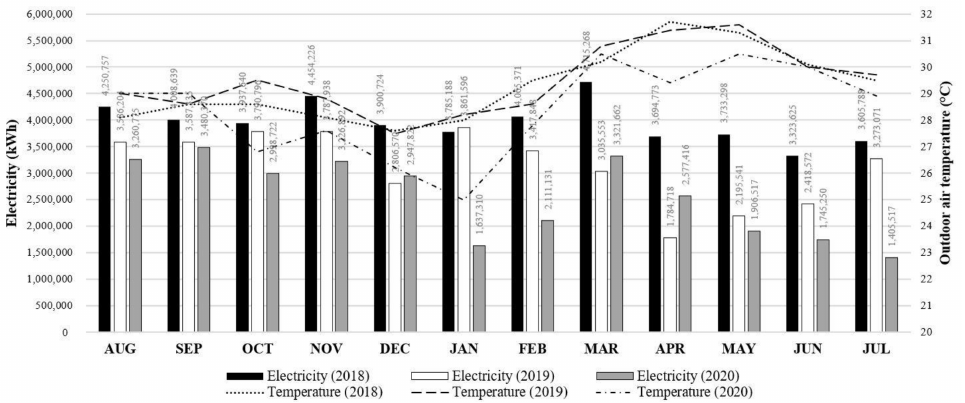
Figure 4. Change of monthly electricity consumption (kWh) from 2018 to 2020 academic years, plotting against their monthly average outdoor air temperature ( ◦